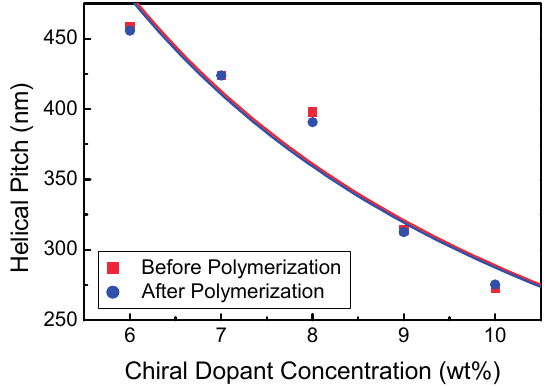
Figure 4. The dependence of the helical pitch on the chiral dopant concentration both before and after polymerization. The red solid squares and blue solid circles are measured results of before and after polymerization, respectively. The red and blue curves are the fitting curves of before and after polymerization,